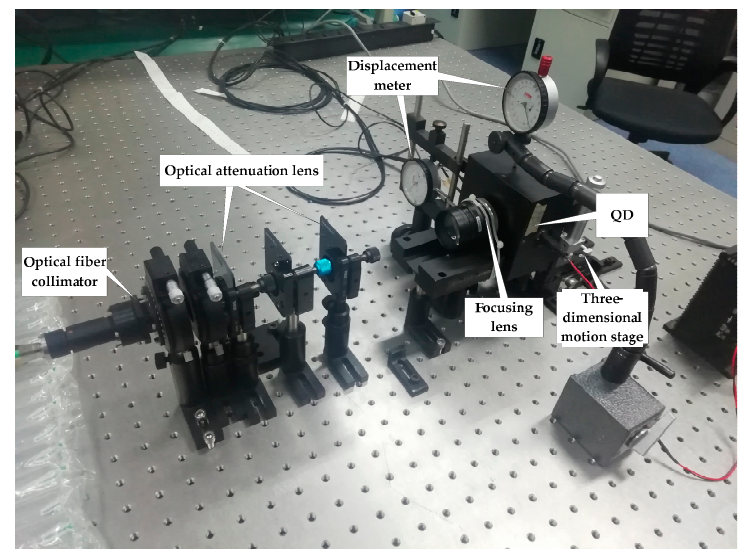
Figure 5. The experimental platform.